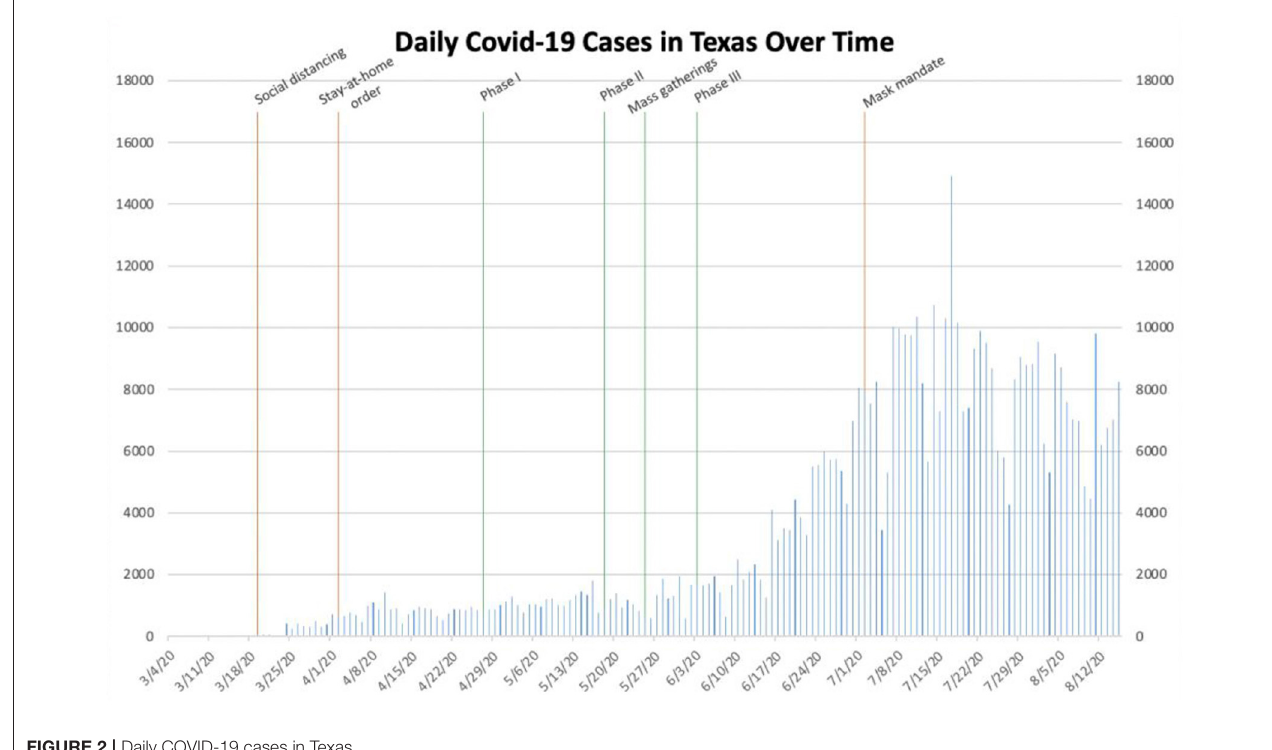
FIGURE 2 | Daily COVID-19 cases in Texas.